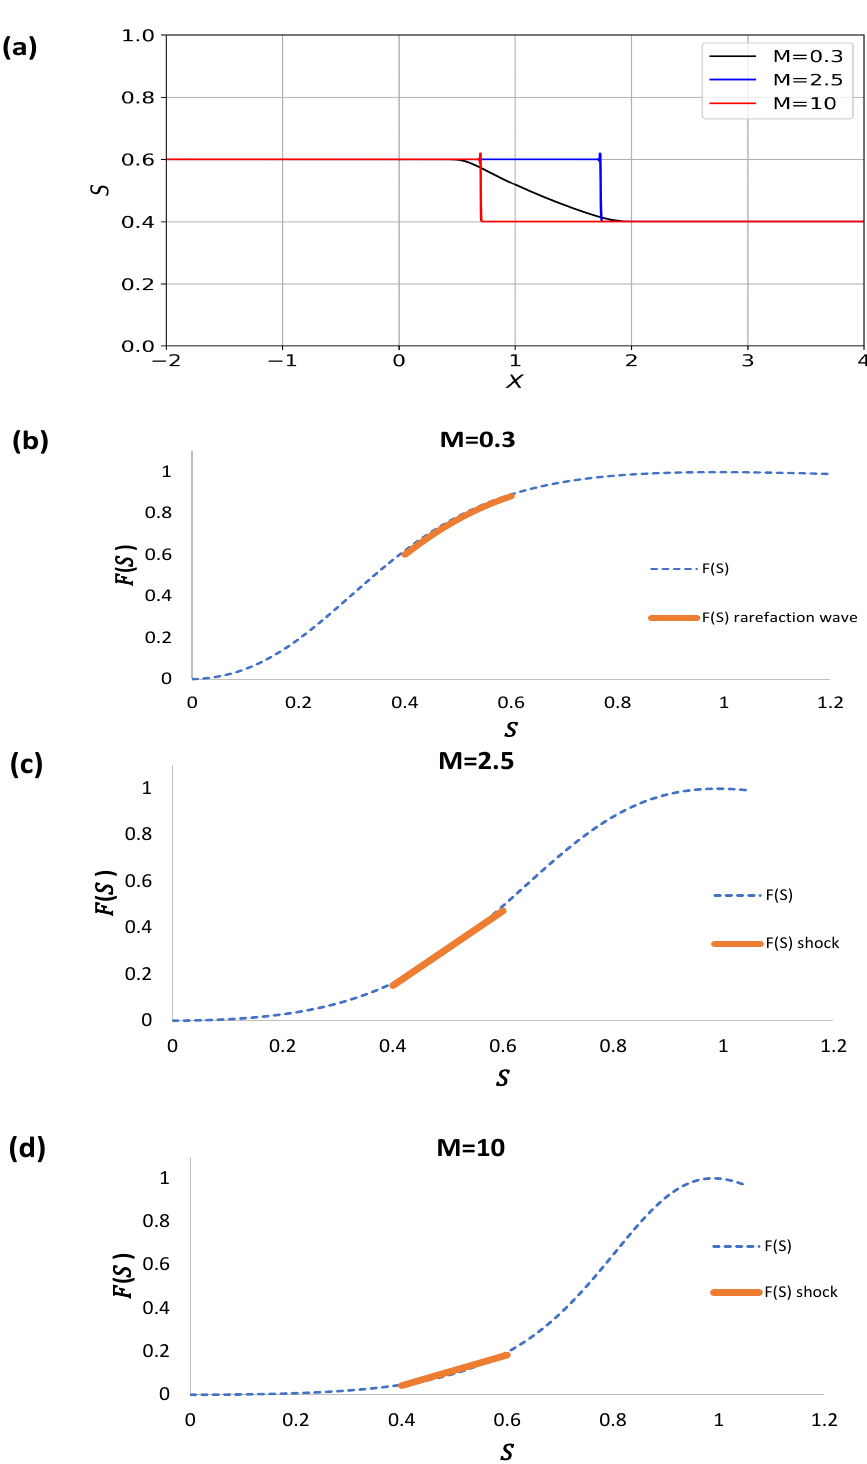
Figure 12. ( a ) Rarefaction wave which evolves into to shocks as the mobility ratio diminishes for S l = 0.6, S r = 0.4, and ε = 0.05. ( b ) The rarefaction wave location in the upper region of the flux curve. ( c , d ) The shocks are represented by straight lines within the saturation interval ( 0.6,0.4 ) . A more complex situation is exhibited here, as a shock trailing the under-compressive shock for S l = 0.8, S r = 0.2, τ = 1 and ε = 0.05 is shown in Figure